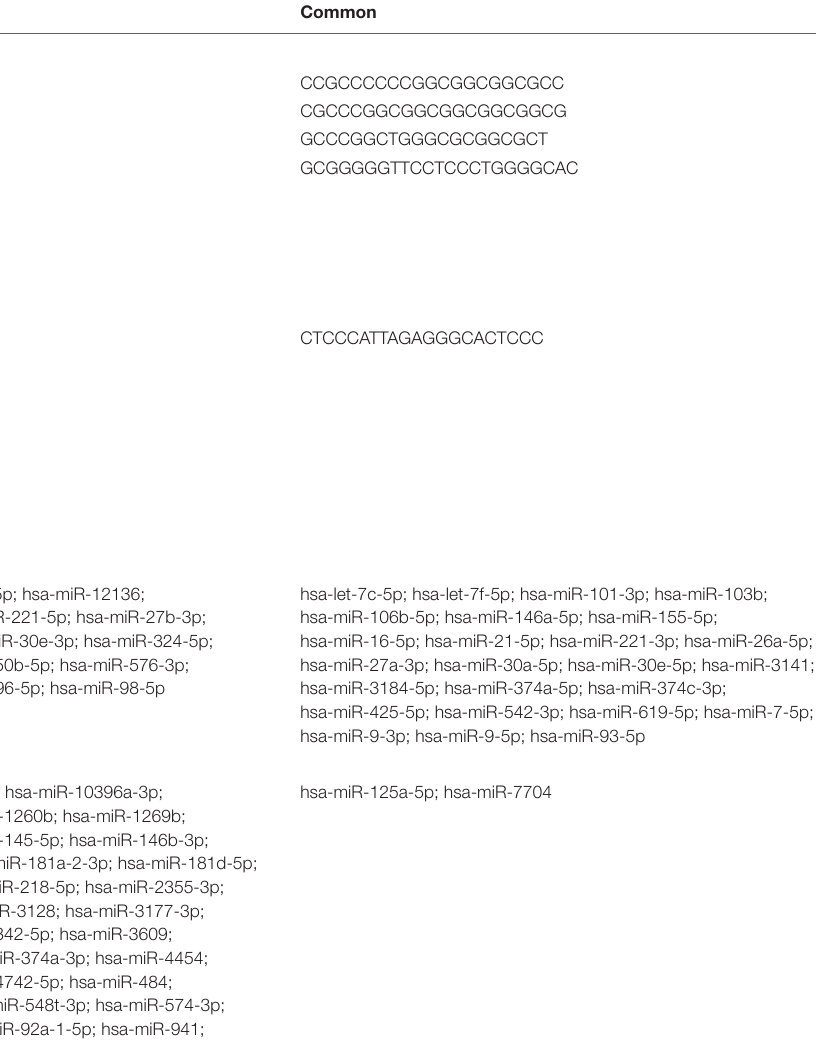
TABLE 1 | List of up- and downregulated novel and known miRNAs. G THP only G VL only